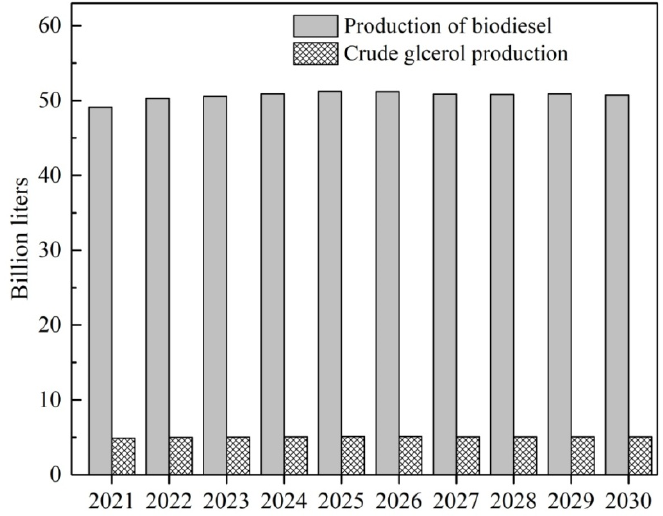
Figure 2. World biodiesel market projections. Adapted from [6].